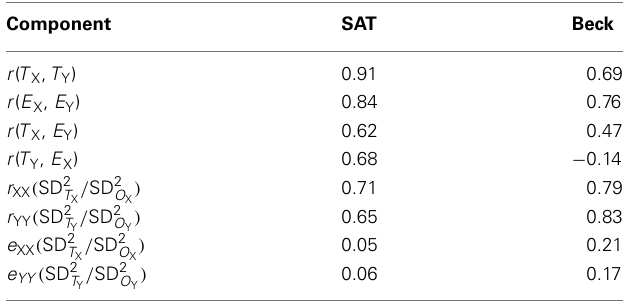
Table 2 |Values for observed score correlation computation for SAT and beck data.